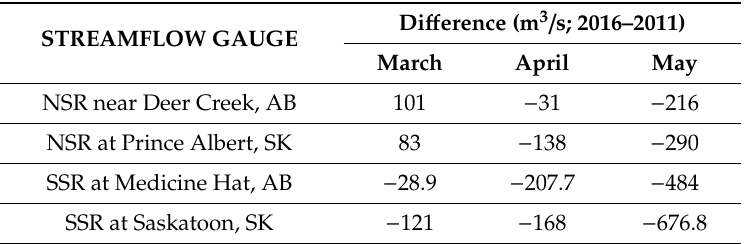
Table 2. Di ff erences in recorded flow (m 3 / s) of the North and South Saskatchewan Rivers (NSR and SSR) in Alberta (AB) and Saskatchewan (SK) between 2011 and 2016.